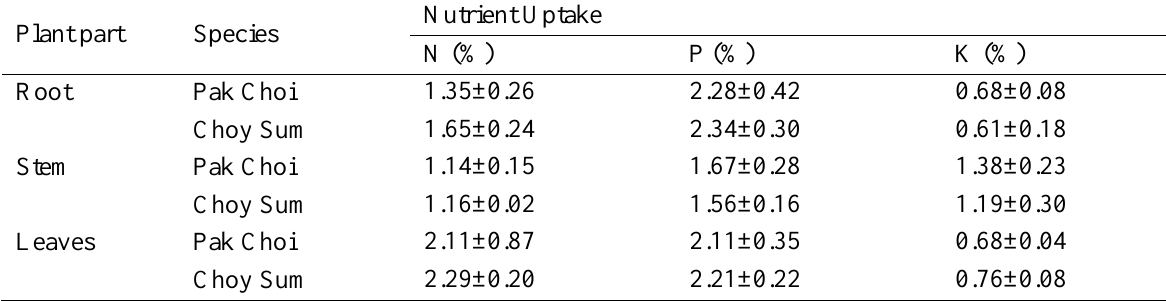
Table 1. Macronutrient contents in plant parts